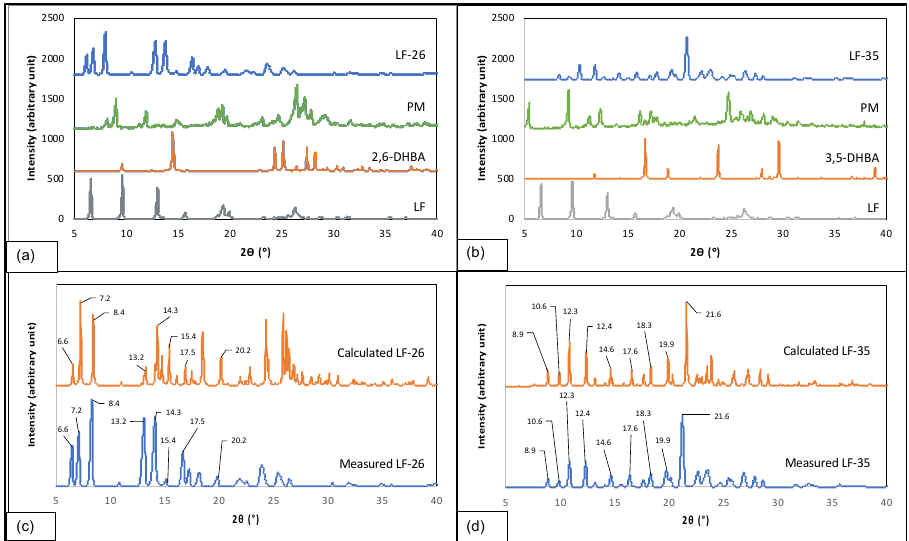
Figure 4. Diffractogram compilation of the multicomponent systems and starting materials of LF- 26 ( a ); LF-35 ( b ); as well as the experimental and calculated patterns from single-crystal data of LF- 26 ( c ) and LF-35 ( d ). Note: LF = levofloxacin; LF-26 = levofloxacin 2.6 dihydroxybenzoic acid multi- component system; LF-35 = levofloxacin 3.5 dihydroxybenzoic acid multicomponent system.